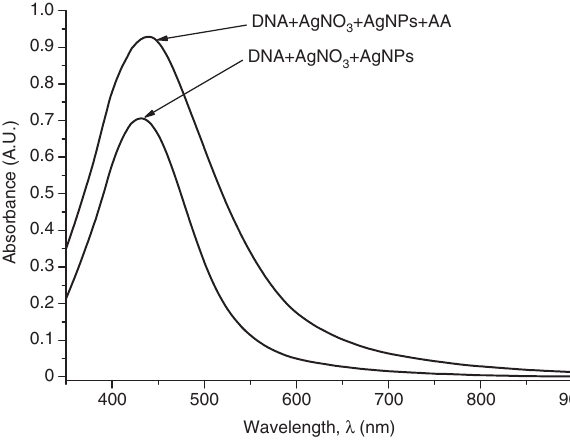
Figure 6 Absorption spectra of AgNPs and the following com- plexes DNA-AgNO -AgNPs and DNA-AgNO 3 – 0.7 × 10 -4 mol/l (Ag 0 ), [DNA] – 1.8 × 10 -4 mol/l (P), [AgNO